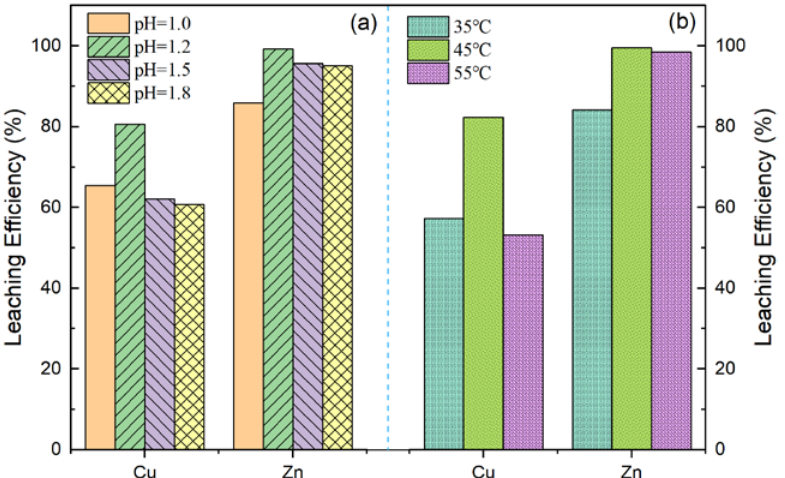
Figure 4. Leaching efficiency for Cu and Zn under ( a ) different pH and ( b ) different temperature conditions by the artificial microbial community.